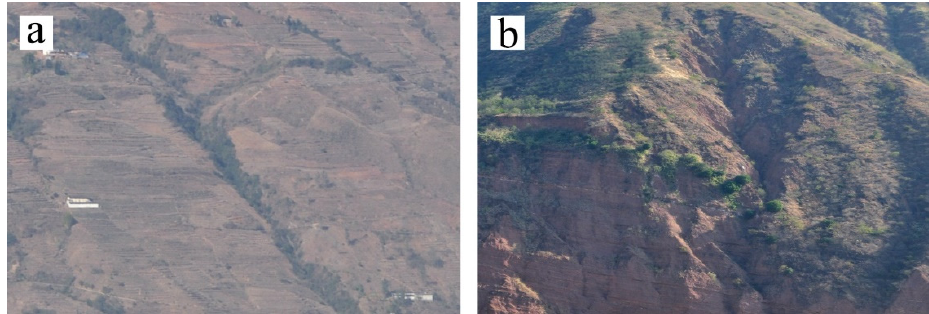
Figure 11. Real view of gullies in Ningnan dry-hot valley: ( a ) Stable gully; ( b ) Active gully.